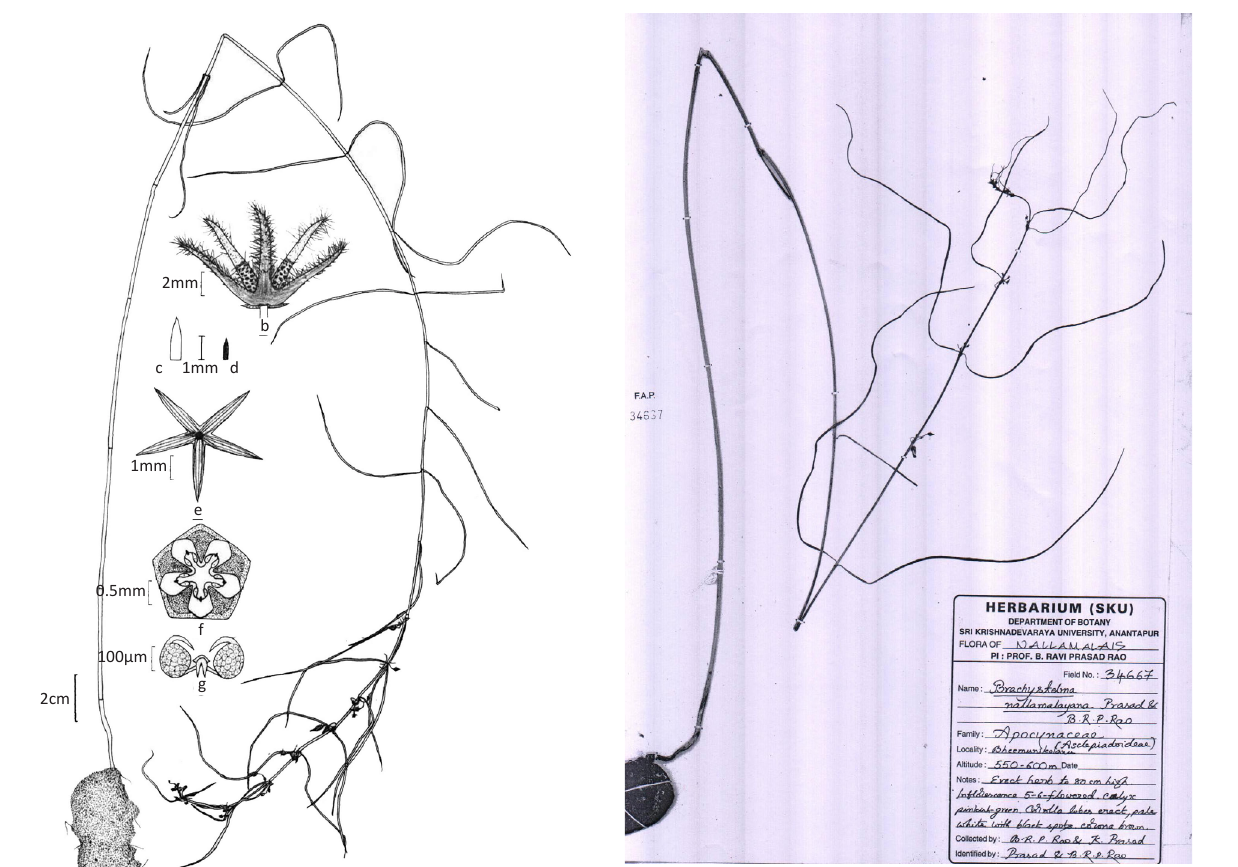
a Figure 1. Brachystelma nallamalayana sp.